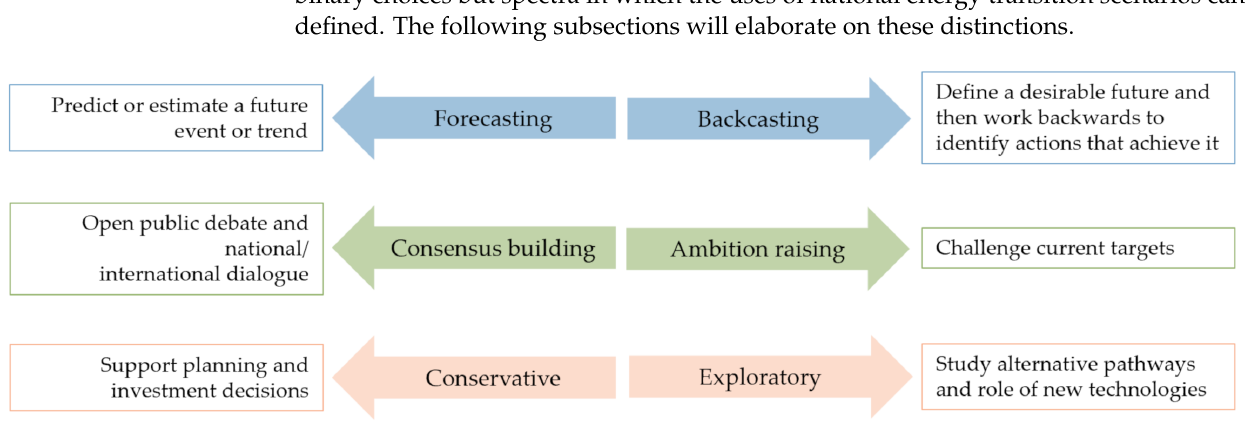
Figure 7. Categorisations of use-cases of LTES